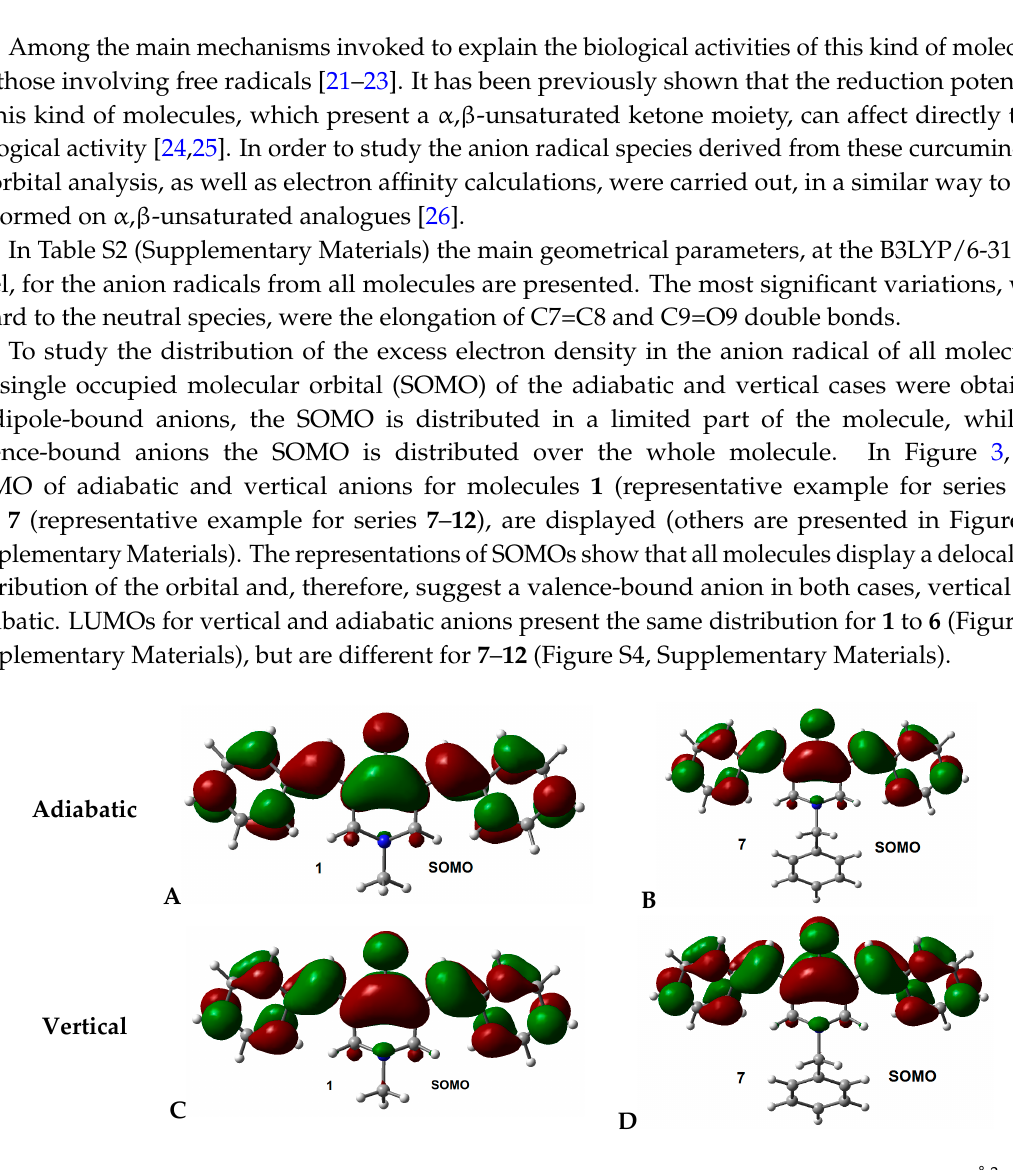
Figure 3 . SOMO of adiabatic and vertical anions for molecules 1 and 7 . Isosurface value = 0.02 e/Å 3 . Calculated AEAs, VEAs, and VDEs at B3LYP/6-31G(d) and B3LYP/6-311+G(2df,p)// B3LYP/6-31G(d)